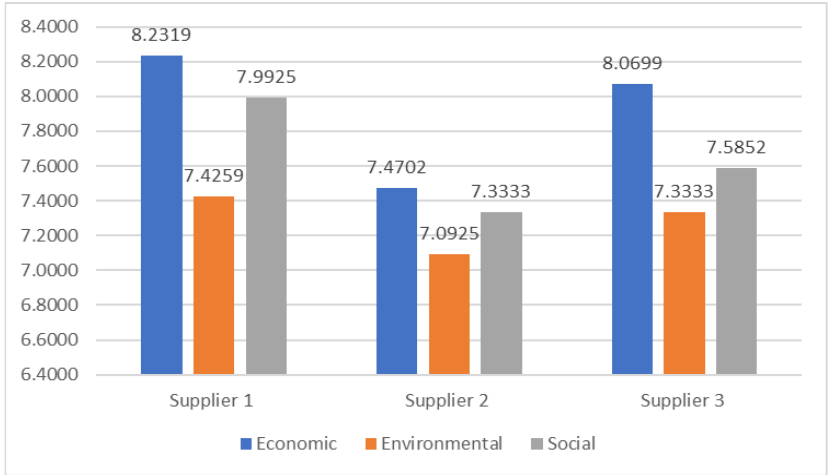
Figure 3. Supplier’s value for each sustainability dimension .